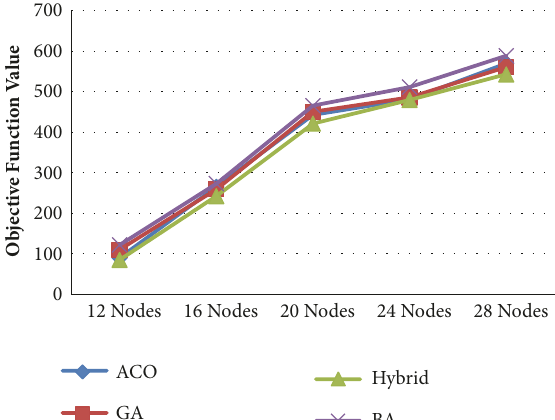
Figure 9: Worst solution.